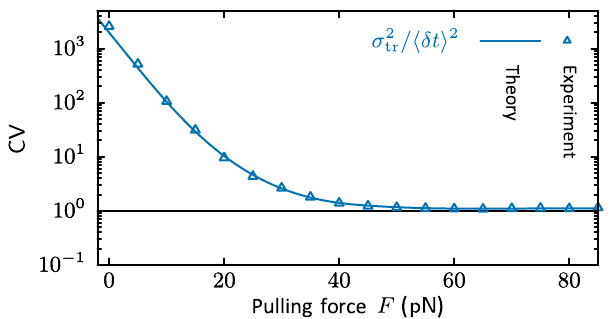
FIG. 18. Coefficientofvariationoftransition-pathtime.Symbols are obtained from 10 4 ruptures as in Fig. 17, and the theory lines are deduced from Eq. (11). We define the mean transition